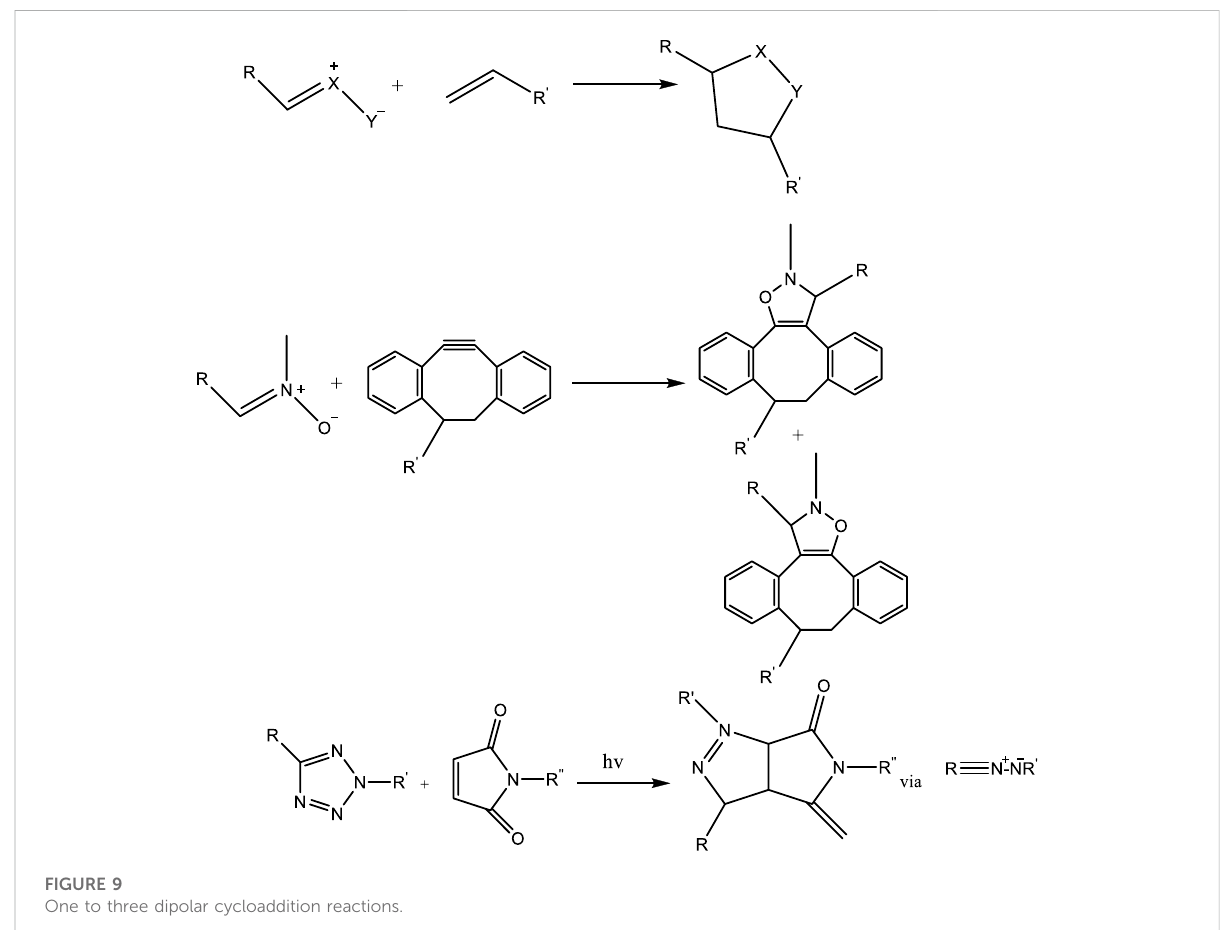
FIGURE 9 One to three dipolar cycloaddition